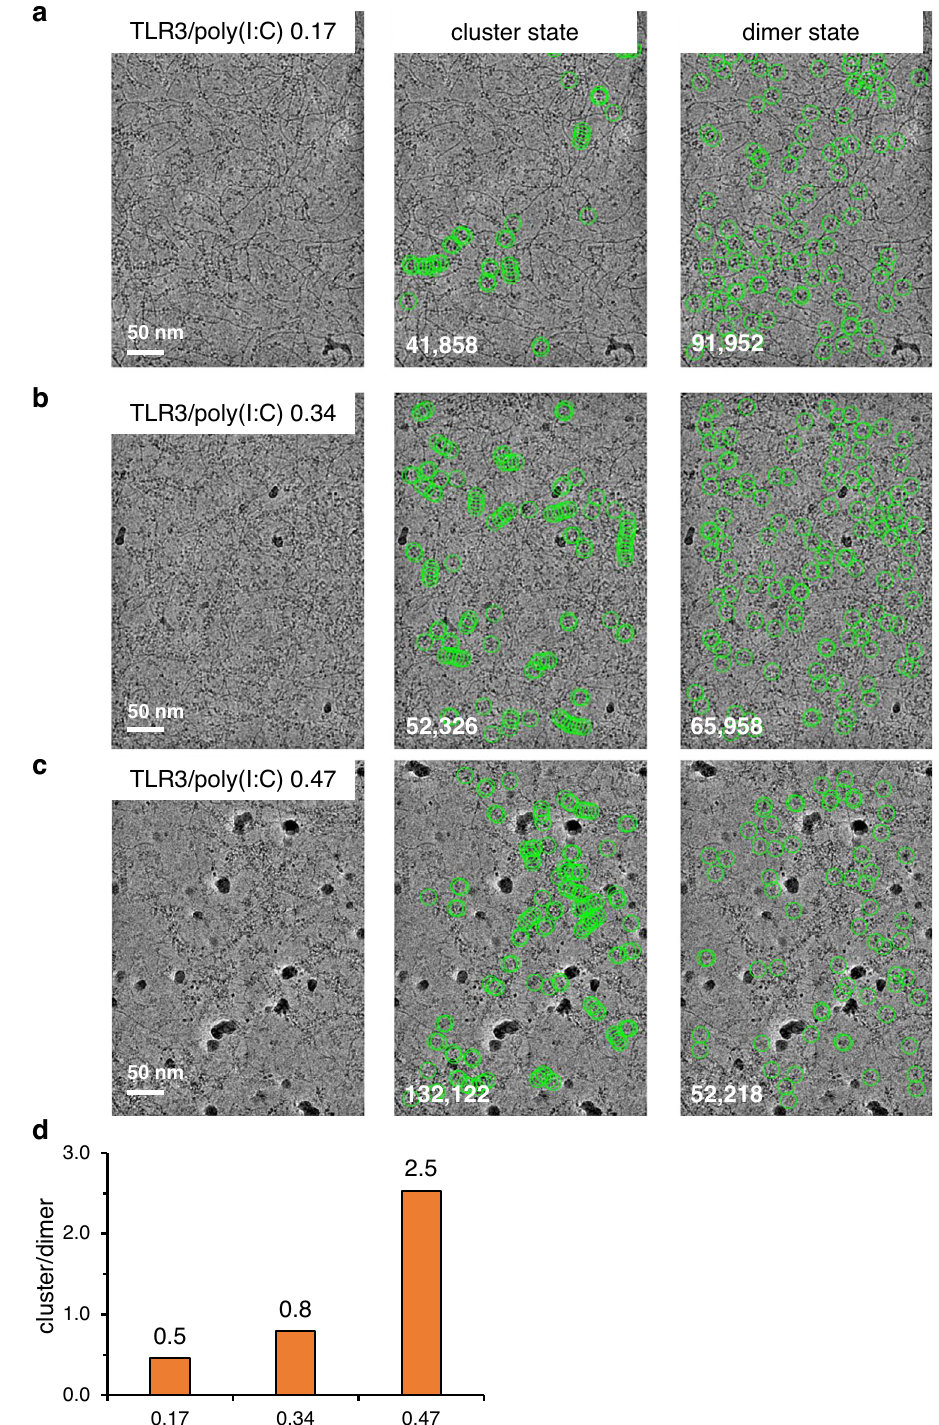
Fig. 3 | Effect of TLR3 concentration on cluster formation. a – c Representative micrographimagesoftheectoTLR3-poly(I:C)complexwithdifferentratiosofTLR3 vs. available binding sites in the poly(I:C). The TLR3s in the clustered (middle) and dimeric states (right) and are marked with green circles. Representative micro- graphsarefrom n =1087( a ), n =1029( b )and n =1081( c )cryo-EMexperimentsets,